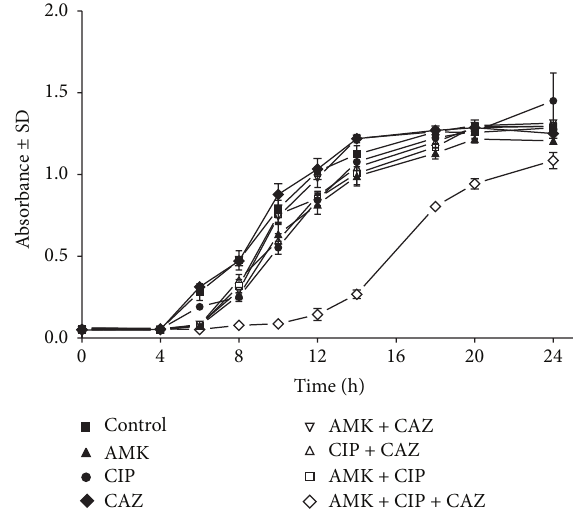
Figure 2: Evaluation of double and triple combinations of cipro- floxacin, amikacin, and ceftazidime against isolate PA14 by time- kill assay in vitro . Isolate PA14 was used to inoculate 100mL of cations-adjusted Muller Hinton broth in 250 mL Erlenmeyer flasks to give initial inoculum size of 1 to 5 × 10 5 CFU/mL. The antibiotics were added alone in double or triple combinations at concentrations equivalent to 1/2 of their MICs. AMK, amikacin; CIP, ciprofloxacin; CAZ,